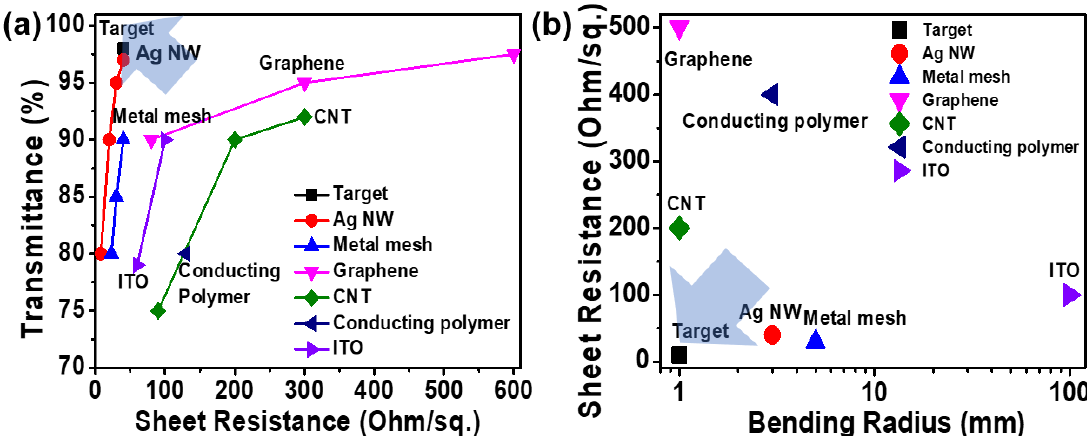
Figure 1. Summarized plot for transparent conductive electrodes: ( a ) Electro-optical properties (Electrical property measurement: four-point probe, contact resistivity, Optical property measurement: haze meter, light transmittance), ( b ) mechano-electric properties [1 – 10].